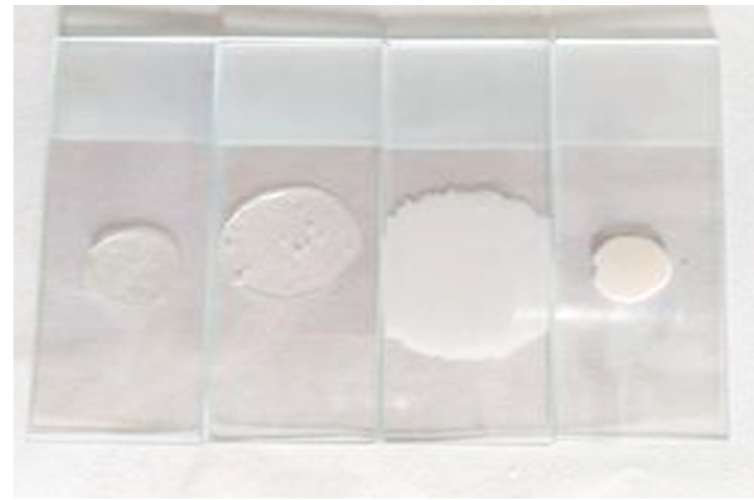
Figure 4. Tests of formulation spreading (0.07 g). From left to right: peel-off mask; water-soluble